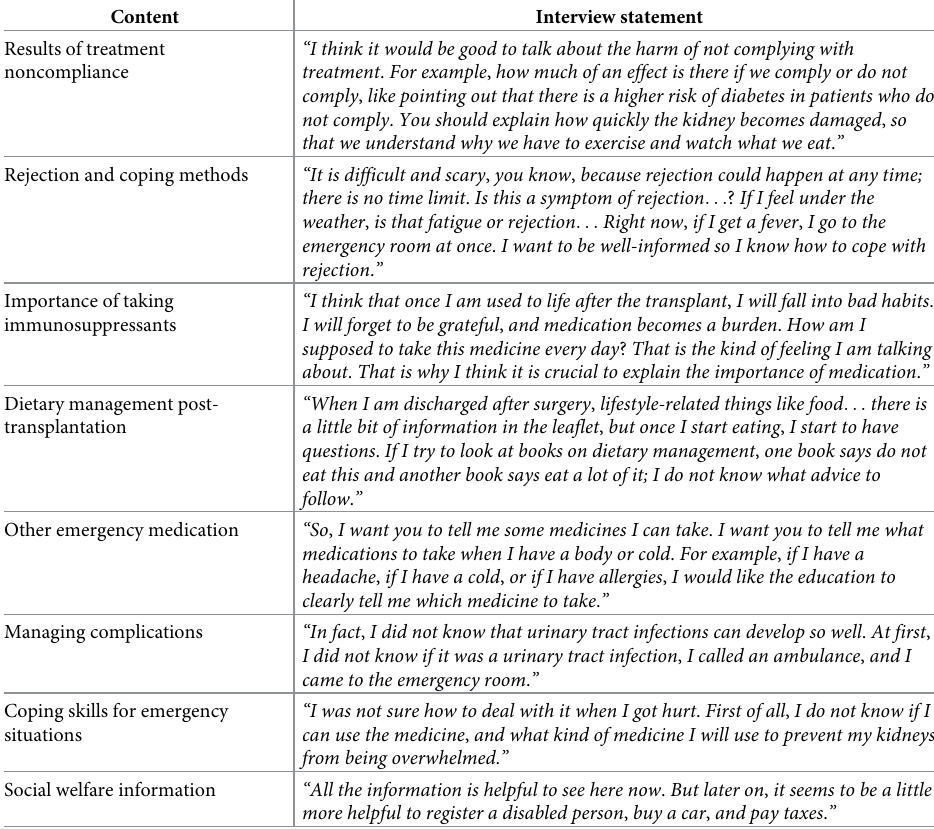
Table 3. Results of patient interviews to determine educational